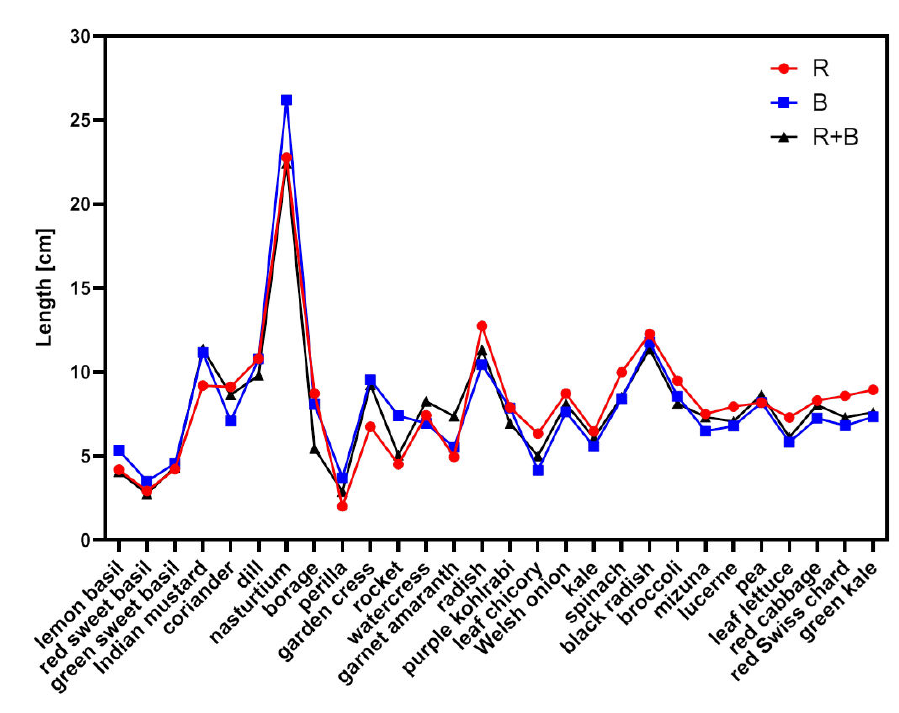
Figure 3. The length (including leaves) of the plants [cm] for 28 microgreen crops depending on light combinations. The Red:Blue ratio for each combination–R light 6.7; B light 0.6; R + B light